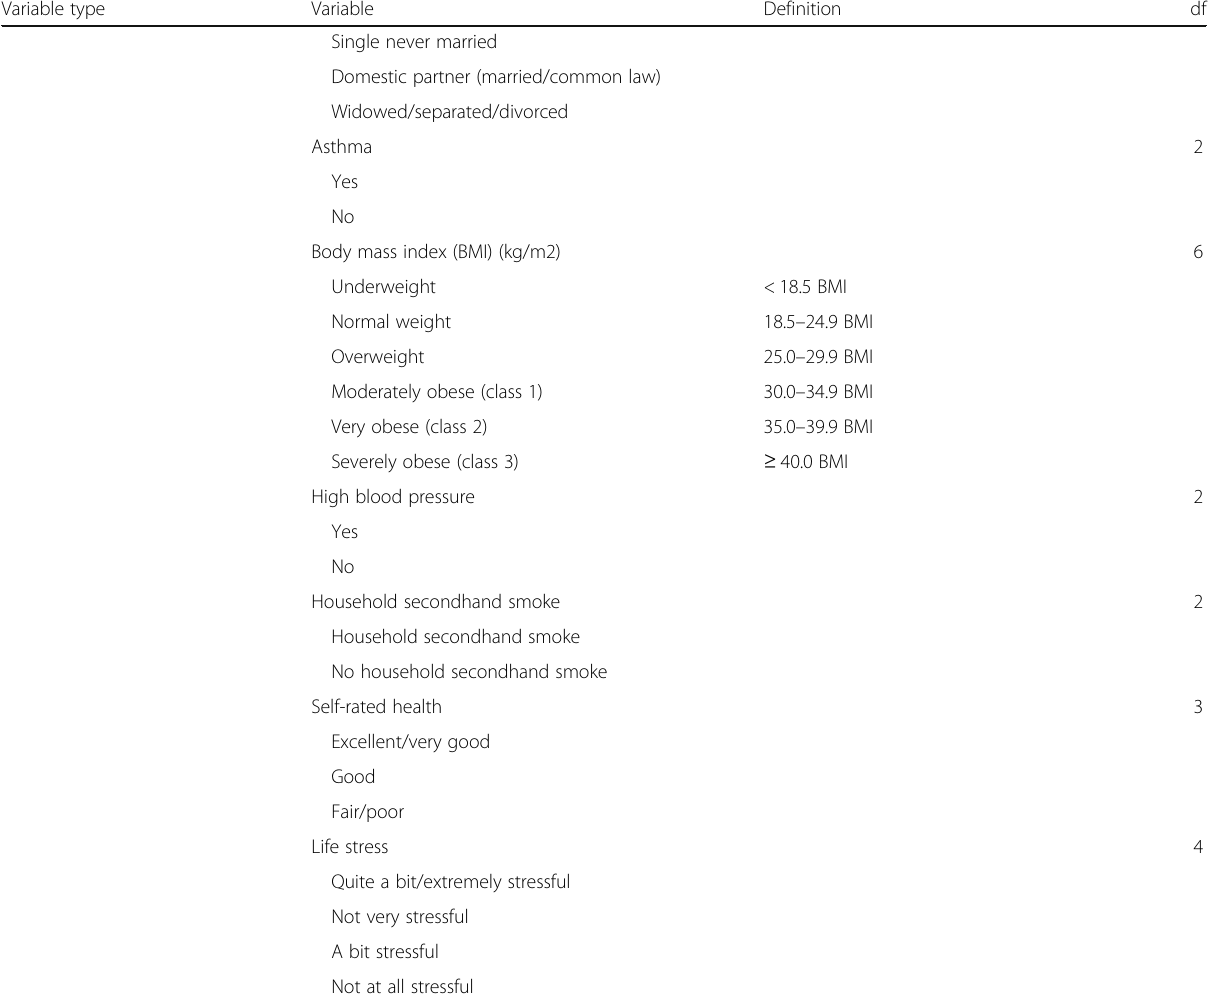
Table 2 Pre-specified definitions of CDPoRT predictors (Continued) Variable